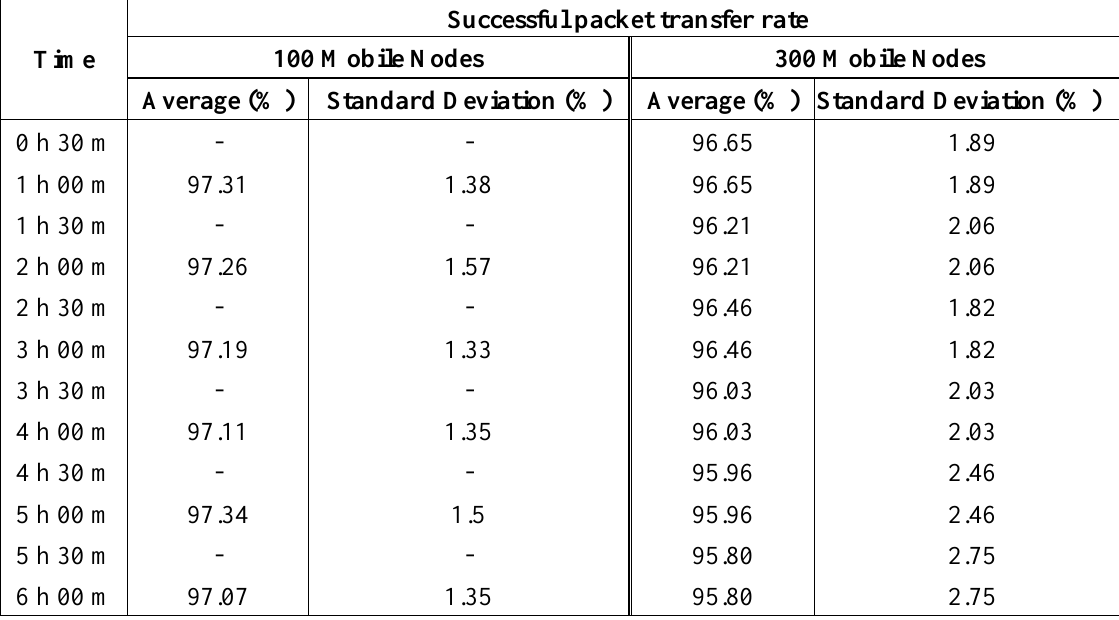
Table 3. Average Successful Packet Transfer Rate according to Number of Mobile Nodes. Time